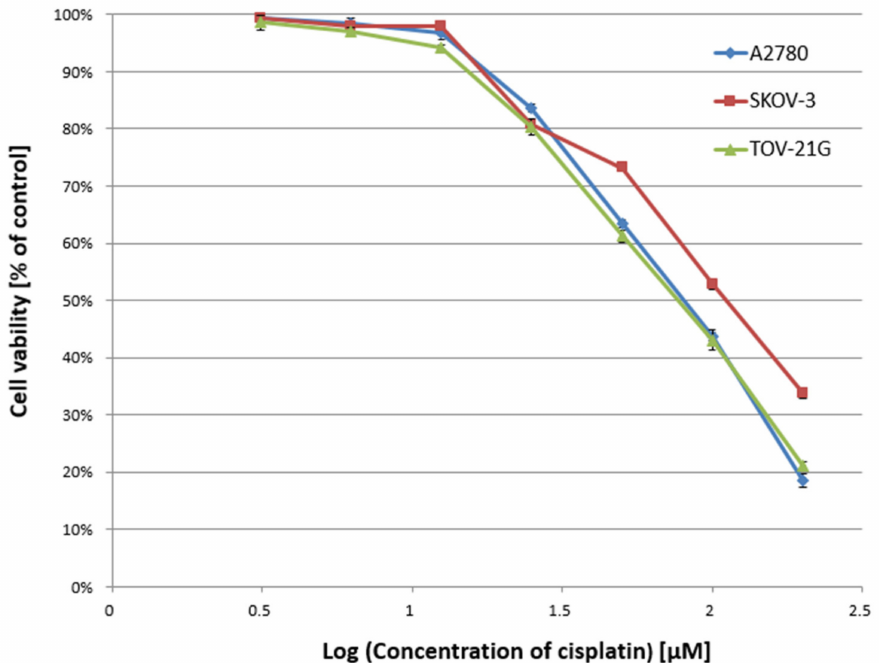
Figure 2. Effect of cisplatin on the viability of A2780, SKOV-3, and TOV-21G human ovarian cancer cells measured by XTT assay and analyzed with ANOVA test. The cells were treated with indicated concentrations of modulators for 24 h. The data are shown as mean All of the results were statistically significant ( p < 0.001) between the cells treated with the different concentrations of modulators and the untreated control